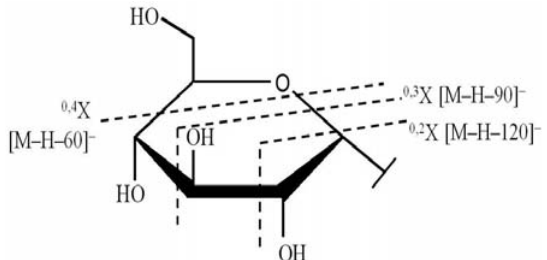
Figure 7. The fragmentation regularity of flavone C-glycosides sugar